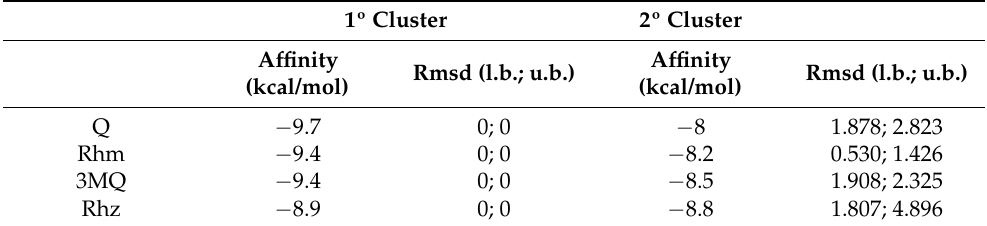
Table 6. Binding free energy and rmsd values of Cdt sPLA2 molecular docking with quercetin derivatives. 1º Cluster 2º Cluster Affinity Rmsd (l.b.; (kcal/mol)